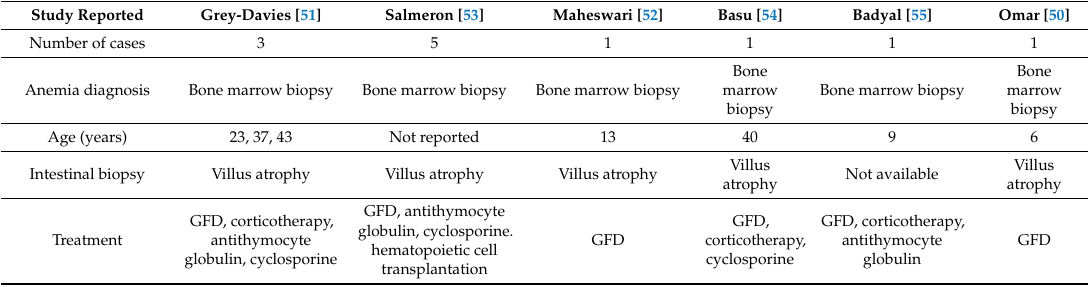
Table 2. Characteristics of patients with aplastic anemia and celiac